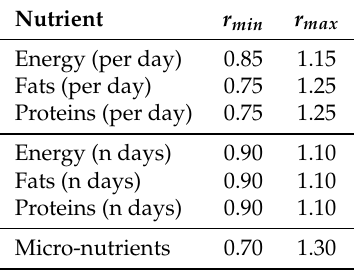
Table 2. Minimum and maximum ranges for nutrient